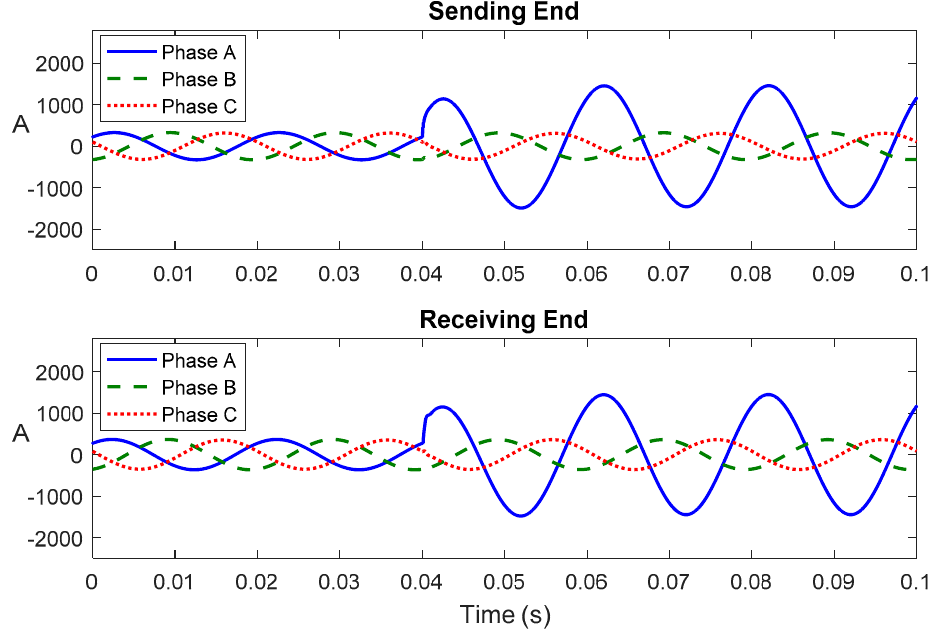
Figure 3. Fault signal from EMTP/ATPDraw of the primary and secondary currents: Phase A short circuit to ground fault at 30% of the length of transmission line.